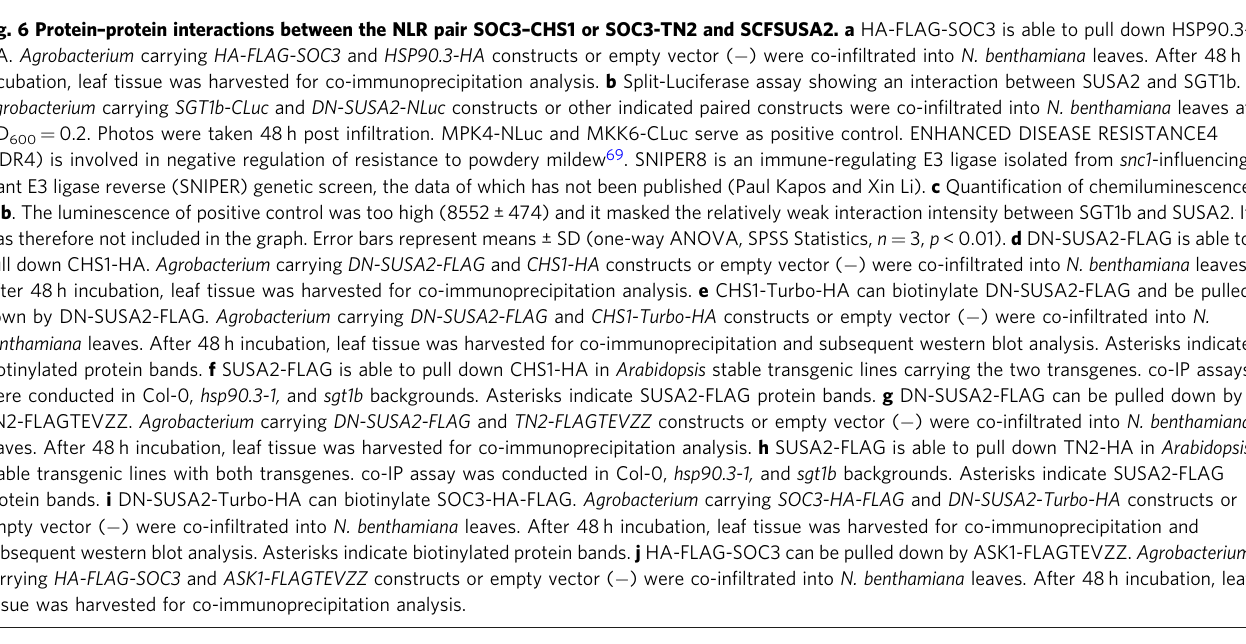
Fig. 6 Protein – protein interactions between the NLR pair SOC3 – CHS1 or SOC3-TN2 and SCFSUSA2. a HA-FLAG-SOC3 is able to pull down HSP90.3- HA. Agrobacterium carrying HA-FLAG-SOC3 and HSP90.3-HA constructs or empty vector ( − ) were co-in fi ltrated into N. benthamiana leaves. After 48 h incubation, leaf tissue was harvested for co-immunoprecipitation analysis. b Split-Luciferase assay showing an interaction between SUSA2 and SGT1b. Agrobacterium carrying SGT1b-CLuc and DN-SUSA2-NLuc constructs or other indicated paired constructs were co-in fi ltrated into N. benthamiana leaves at OD 600 = 0.2. Photos were taken 48 h post in fi ltration. MPK4-NLuc and MKK6-CLuc serve as positive control. ENHANCED DISEASE RESISTANCE4 (EDR4) is involved in negative regulation of resistance to powdery mildew 69 . SNIPER8 is an immune-regulating E3 ligase isolated from snc1 -in fl uencing plant E3 ligase reverse (SNIPER) genetic screen, the data of which has not been published (Paul Kapos and Xin Li). c Quanti fi cation of chemiluminescence in b . The luminescence of positive control was too high (8552 ± 474) and it masked the relatively weak interaction intensity between SGT1b and SUSA2. It was therefore not included in the graph. Error bars represent means ± SD (one-way ANOVA, SPSS Statistics, n = 3, p < 0.01). d DN-SUSA2-FLAG is able to pull down CHS1-HA. Agrobacterium carrying DN-SUSA2-FLAG and CHS1-HA constructs or empty vector ( − ) were co-in fi ltrated into N. benthamiana leaves. After 48 h incubation, leaf tissue was harvested for co-immunoprecipitation analysis. e CHS1-Turbo-HA can biotinylate DN-SUSA2-FLAG and be pulled down by DN-SUSA2-FLAG. Agrobacterium carrying DN-SUSA2-FLAG and CHS1-Turbo-HA constructs or empty vector ( − ) were co-in fi ltrated into N. benthamiana leaves. After 48 h incubation, leaf tissue was harvested for co-immunoprecipitation and subsequent western blot analysis. Asterisks indicate biotinylated protein bands. f SUSA2-FLAG is able to pull down CHS1-HA in Arabidopsis stable transgenic lines carrying the two transgenes. co-IP assays were conducted in Col-0, hsp90.3-1, and sgt1b backgrounds. Asterisks indicate SUSA2-FLAG protein bands. g DN-SUSA2-FLAG can be pulled down by TN2-FLAGTEVZZ. Agrobacterium carrying DN-SUSA2-FLAG and TN2-FLAGTEVZZ constructs or empty vector ( − ) were co-in fi ltrated into N. benthamiana leaves. After 48 h incubation, leaf tissue was harvested for co-immunoprecipitation analysis. h SUSA2-FLAG is able to pull down TN2-HA in Arabidopsis stable transgenic lines with both transgenes. co-IP assay was conducted in Col-0, hsp90.3-1, and sgt1b backgrounds. Asterisks indicate SUSA2-FLAG protein bands. i DN-SUSA2-Turbo-HA can biotinylate SOC3-HA-FLAG. Agrobacterium carrying SOC3-HA-FLAG and DN-SUSA2-Turbo-HA constructs or empty vector ( − ) were co-in fi ltrated into N. benthamiana leaves. After 48 h incubation, leaf tissue was harvested for co-immunoprecipitation and subsequent western blot analysis. Asterisks indicate biotinylated protein bands. j HA-FLAG-SOC3 can be pulled down by ASK1-FLAGTEVZZ. Agrobacterium carrying HA-FLAG-SOC3 and ASK1-FLAGTEVZZ constructs or empty vector ( − ) were co-in fi ltrated into N. benthamiana leaves. After 48 h incubation, leaf tissue was harvested for co-immunoprecipitation